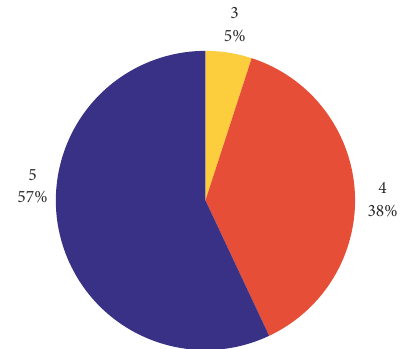
Figure 6. Satisfaction with the overall service in Bristol: 1 – not at all satisfied; 2 – slightly satisfied; 3 – moderately satisfied; 4 – satisfied; 5 – very